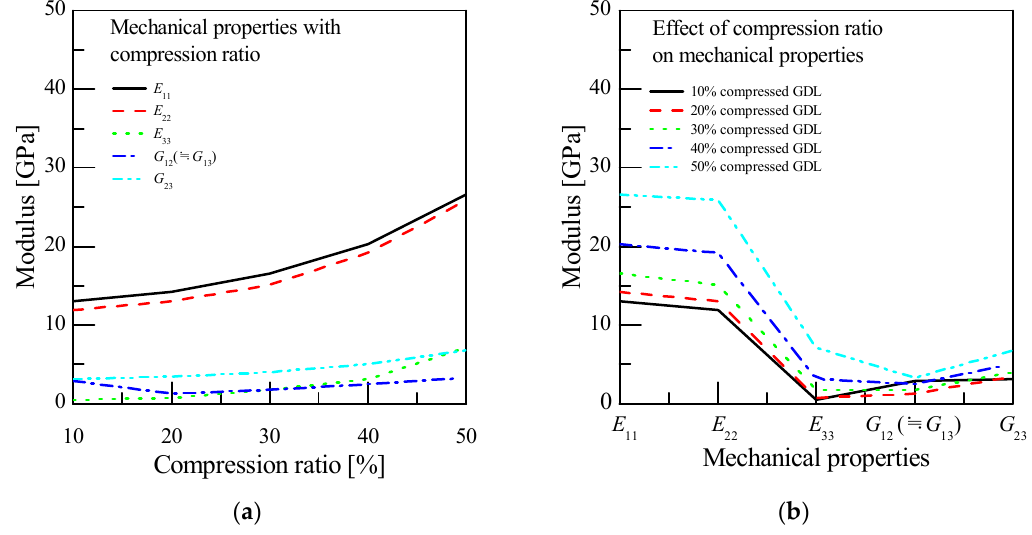
Figure 7. Analysis results according to compression ratios: ( a ) Mechanical properties with compression ratio; ( b ) effect of compression ratio on mechanical properties.